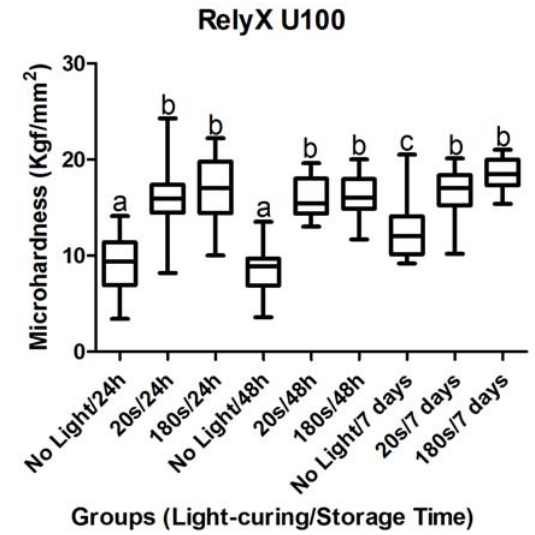
Figure 2. The mean values (Kgf/mm 2 ) were analyzed according to exposure time of light-curing and storage time for RelyX U100. Different letters (A–C) indicate statistically significant difference at 5% level (Tukey’s test; P <